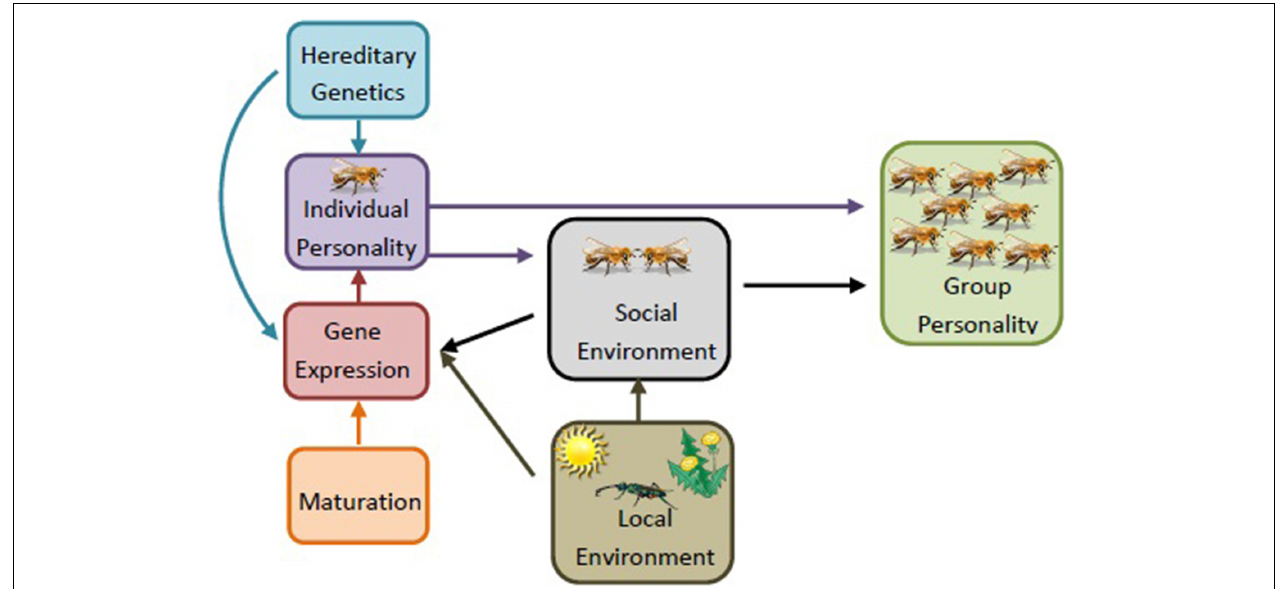
FIGURE 3 | Sociogenomics of personality. An individual’s personality develops from a combination of hereditary genetics and differential gene expression. The group-level personality, then, is influenced by a combination of individual personalities and the social interactions among individuals (e.g., social environment). The social environment, age, and local environment (e.g., presence of parasites and predators, food availability/consistency, variation in climate) can influence the gene expression of the individual. These changes can influence an individual’s personality, and therefore the